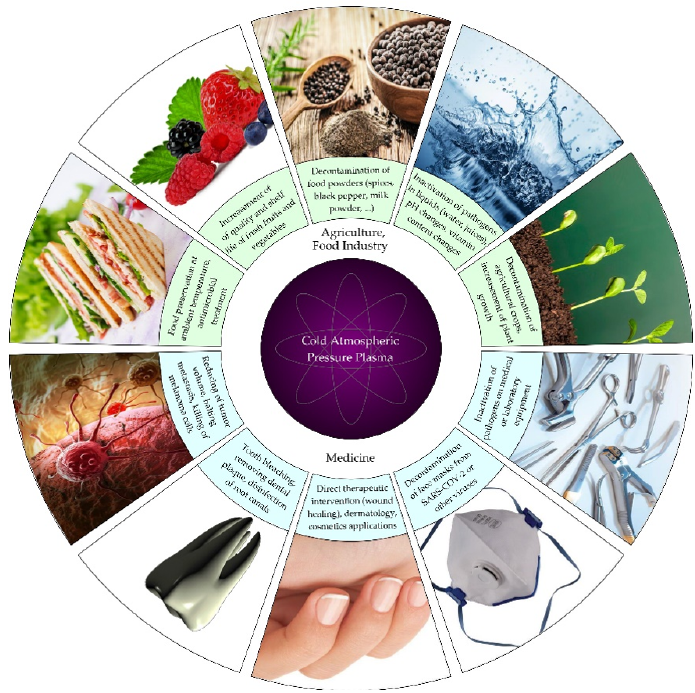
Figure 3. Schematic illustration of selected applications of CAPP treatment in medicine, agriculture and food